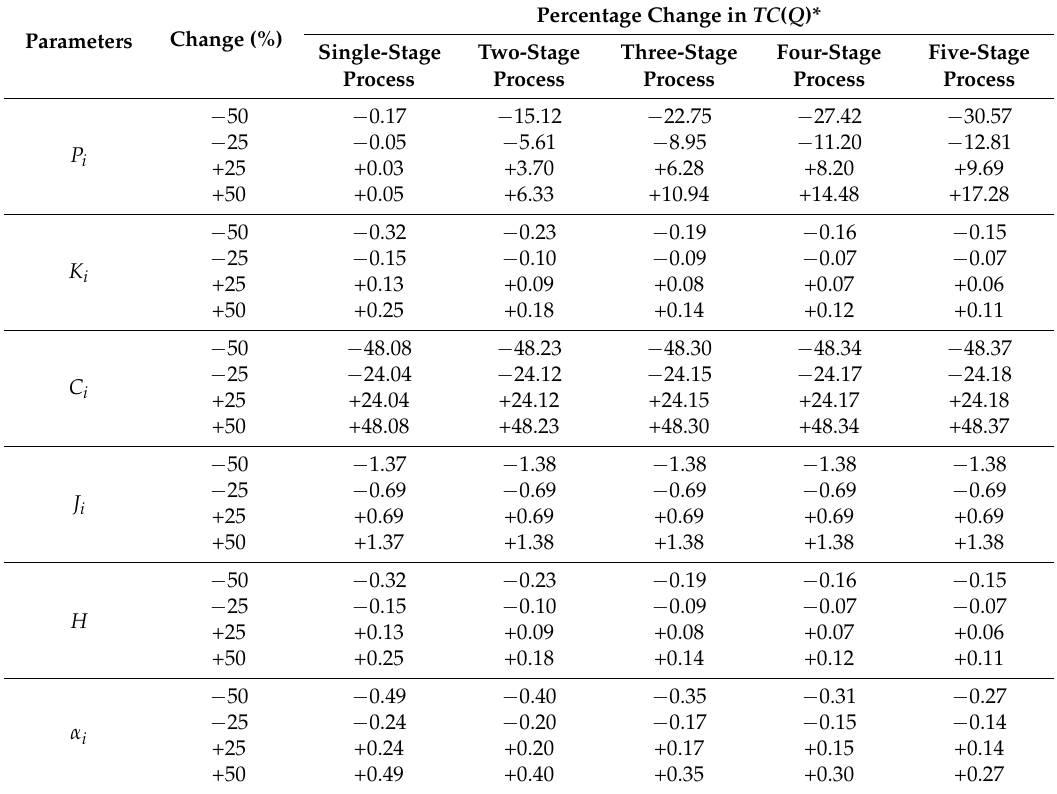
Table 3. Sensitivity analysis of key parameters for Example 2.